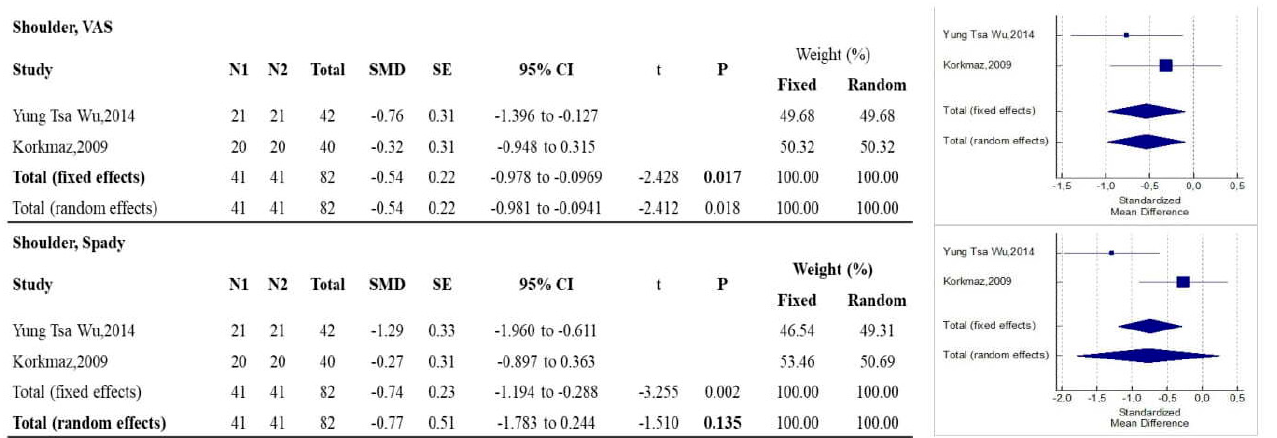
pain according to VAS measurements ( p = 0.017), while there were no statistically signif- icant differences with regard to function measured using SPADI ( p = 0.035).